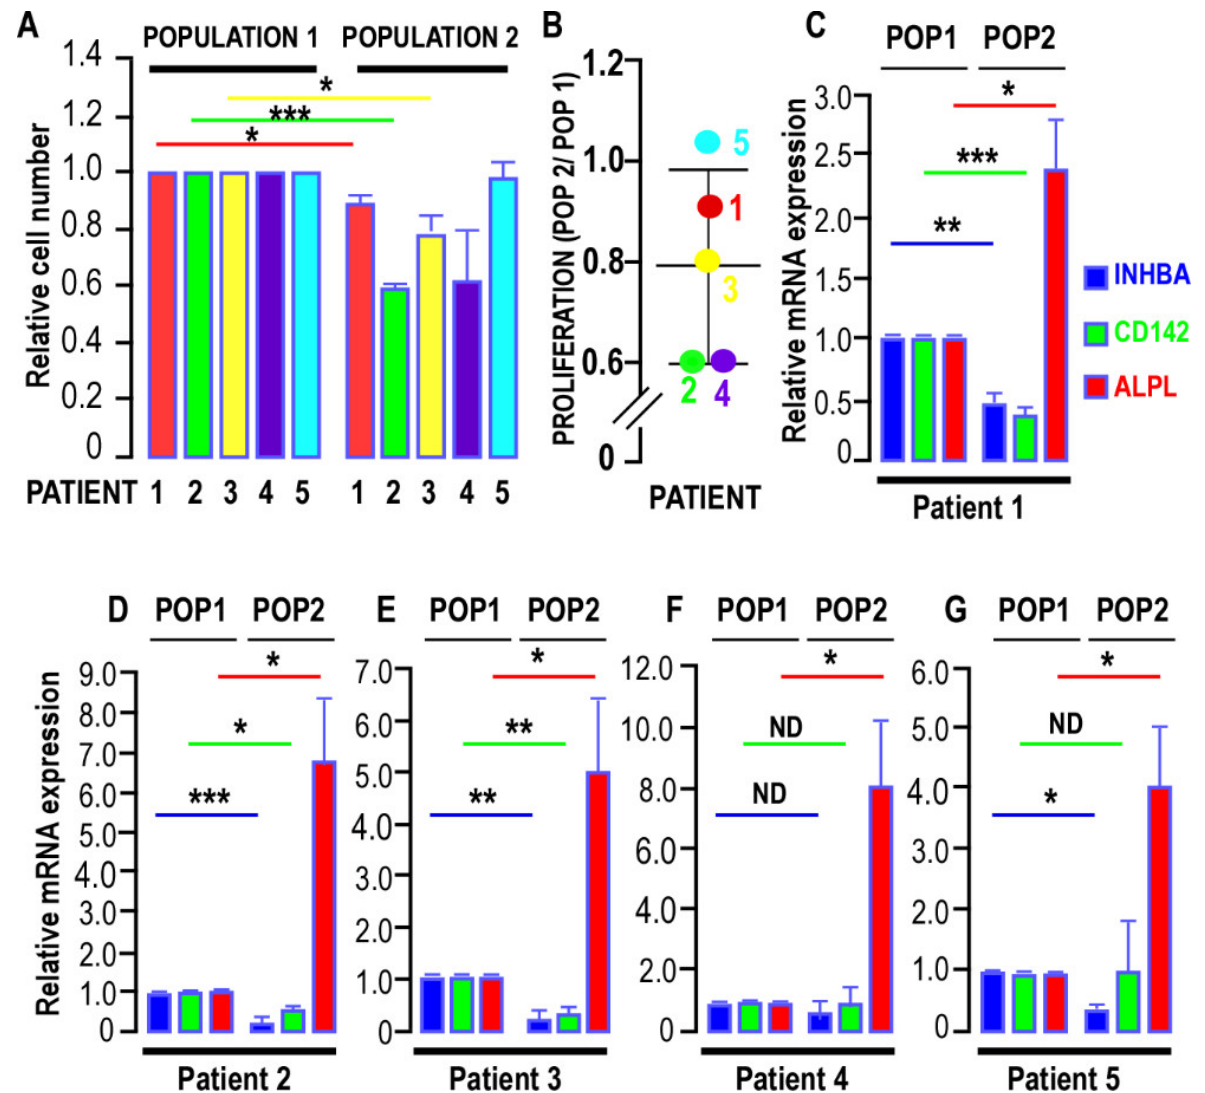
Figure 1. Proliferation and marker expression of the two breast adipose progenitor cell (APC) populations. ( A , B ) Proliferation of the two populations of APC isolated from human breast. Cells were seeded in 12-well plates, and proliferation was measured as the number of cells in the wells after 5 days of culture and normalized to the cells present in Population 1. The means ± SEMs were calculated from three independent experiments, with determinations performed in quadruplicate (* p < 0.05, *** p < 0.001). The ratio of the proliferation rate for Population 2, as compared to Population 1, is presented in (B). ( C – G ) Expression of INHBA, CD142 , and ALPL (MSCA1) was assessed by real-time RT-PCR and normalized for the expression of 36B4 mRNA for all the patients. The means ± SEMs were calculated from four (Patients 1, 2, 3, and 4) and five (Patient 5) independent experiments, with determinations performed in duplicate (* p < 0.05, ** p < 0.01, and *** p < 0.001; ND, not different).